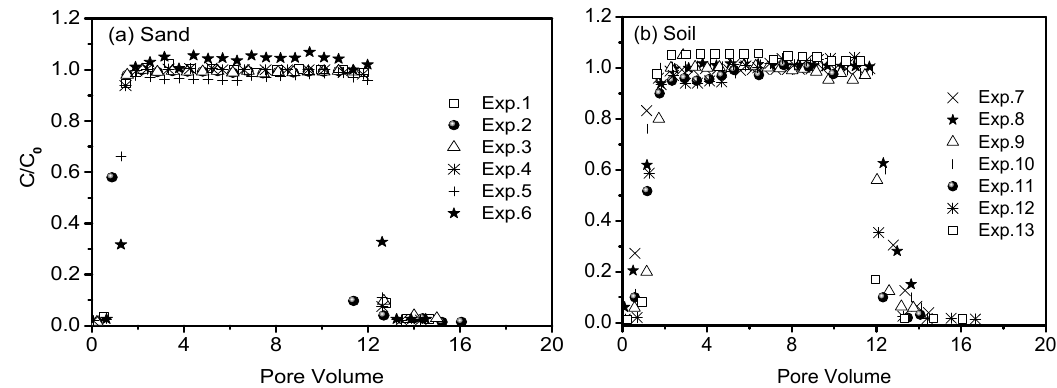
Figure 2. Breakthrough curves of bromide ion from columns repacked with sand ( a ) and soil ( b ) under saturated flow conditions.